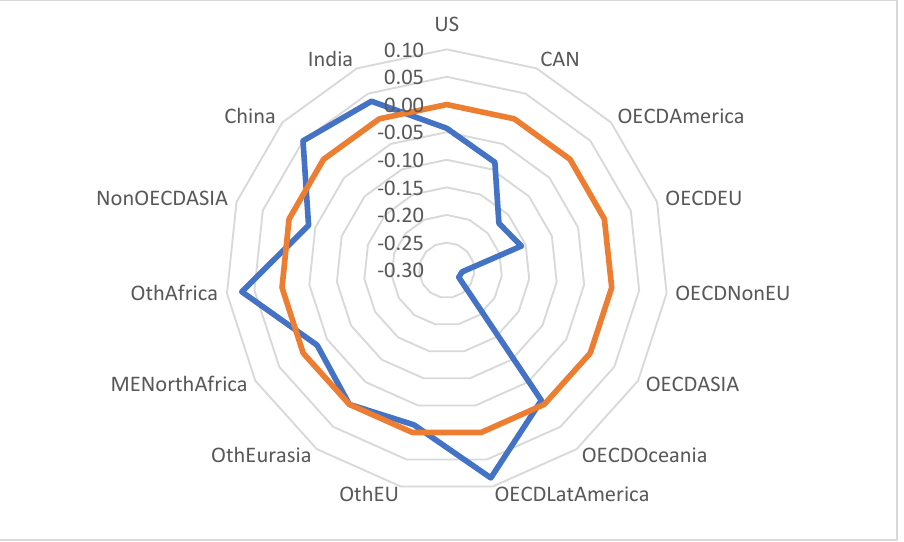
Figure 3. Correlation diagram of the effects of circular economy implementation on plastic use by region (PWCR vs PUR).